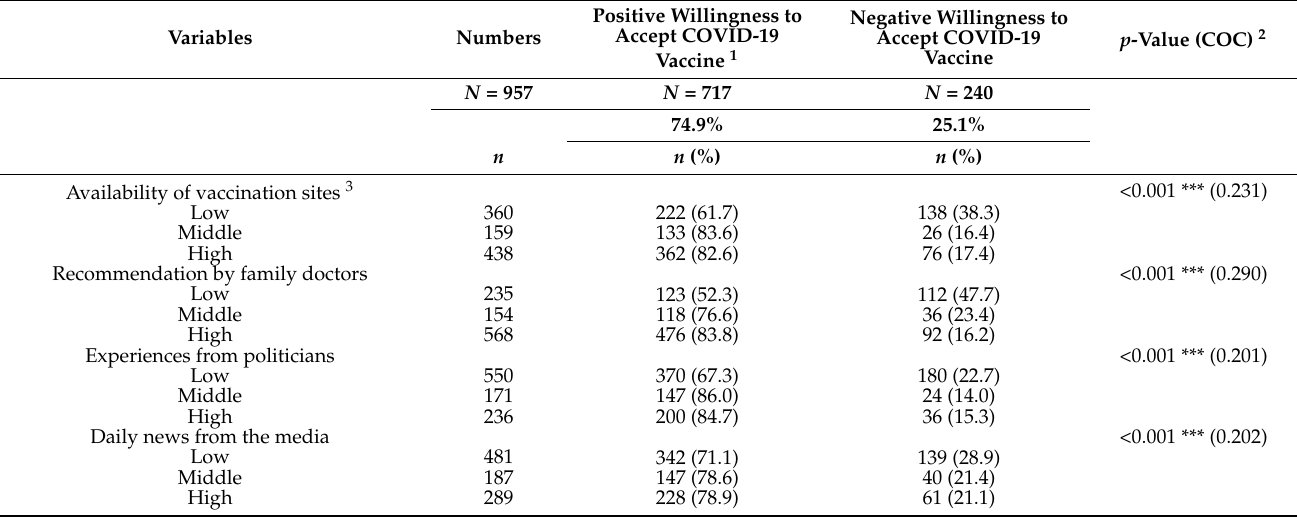
Table 3. Possible factors affecting the willingness of elderly individuals to accept the COVID-19 vaccines.